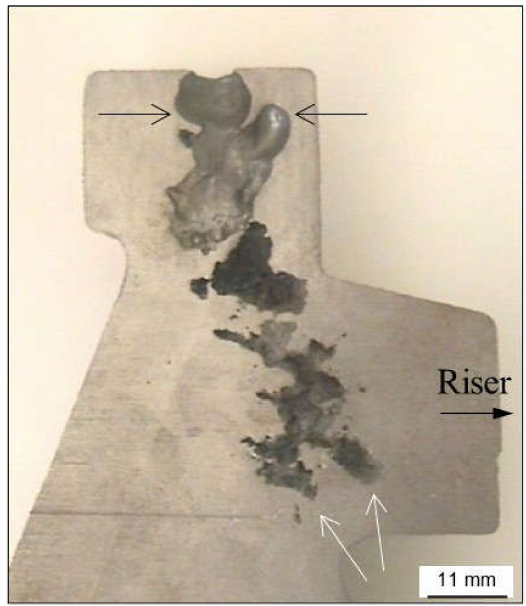
Figure 69. Shrinkage found in a small section ductile iron